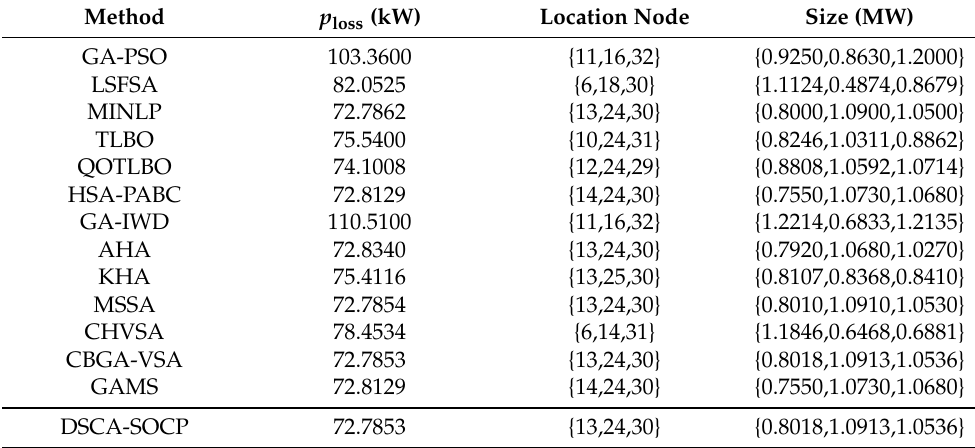
Table 2. Optimal location and sizing of DGs in the 33-node test feeder for the proposed and compara- tive